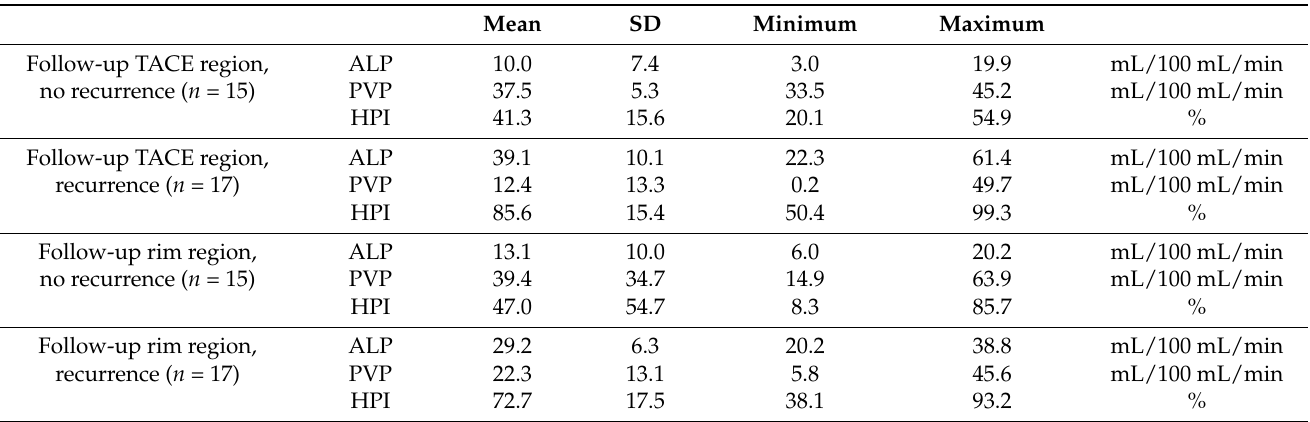
Table 3. Perfusion-CT data, follow-up in initial